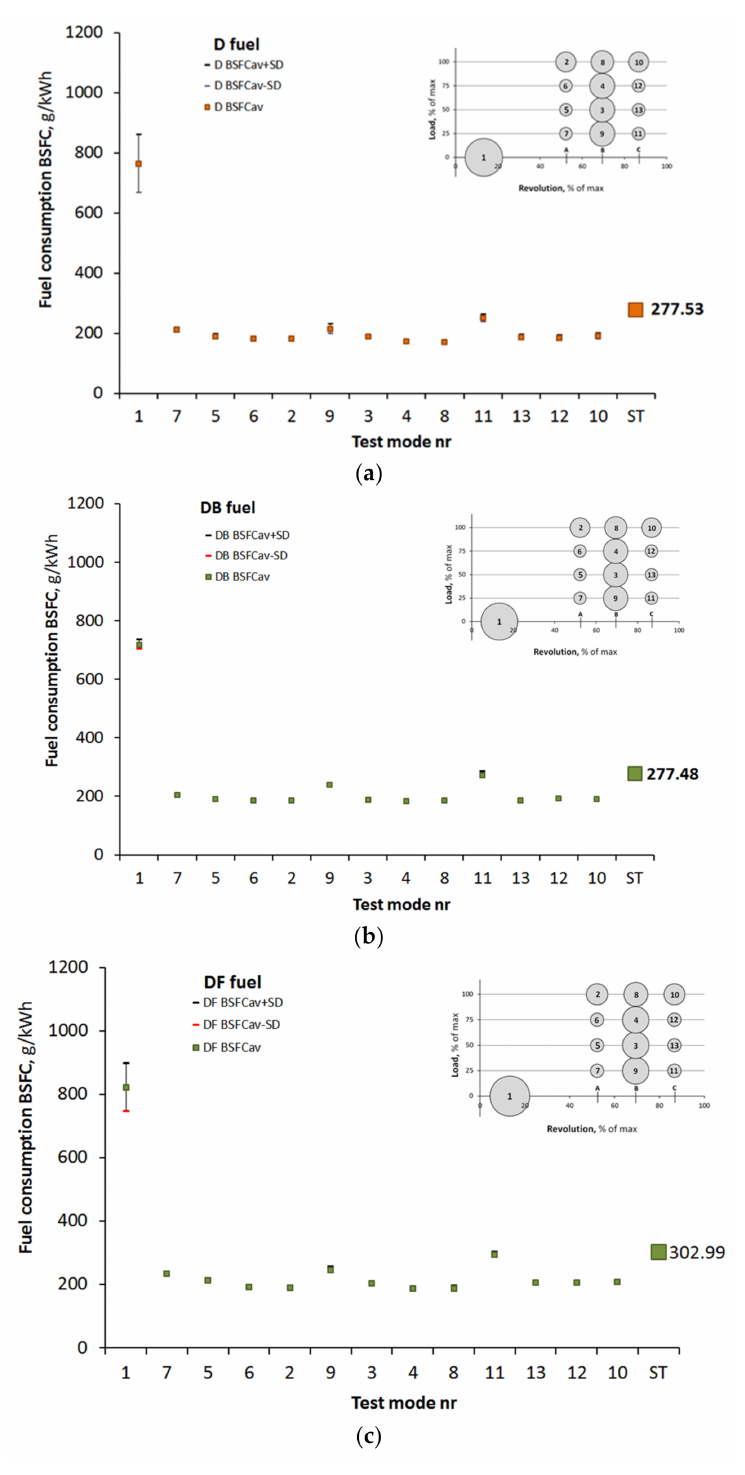
Figure 3. Fuel consumption (brake-specific fuel consumption (BSFC)) of the engine in ESC 13 mode test fed with Diesel fuel ( a ), with DB fuel ( b ), and with DF fuel ( c ). The values determined (respectively) for the entire test were given as ST (Sum of Test) and are marked with the largest squares in the diagrams. Comparison of these values leads to the conclusion that the differences are probably not important (more information about the testing method of the significance of differences is given later in this